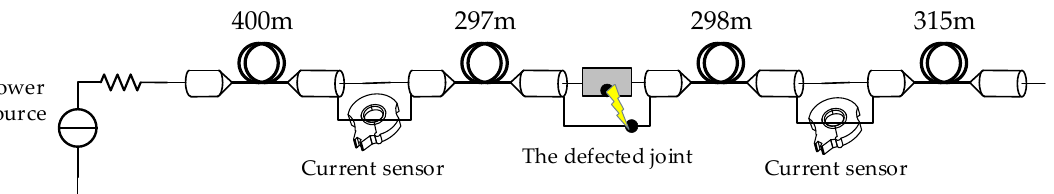
Figure 22. The schematic diagram of the test cable circuit. Sensors 2019 , 19 , 2083